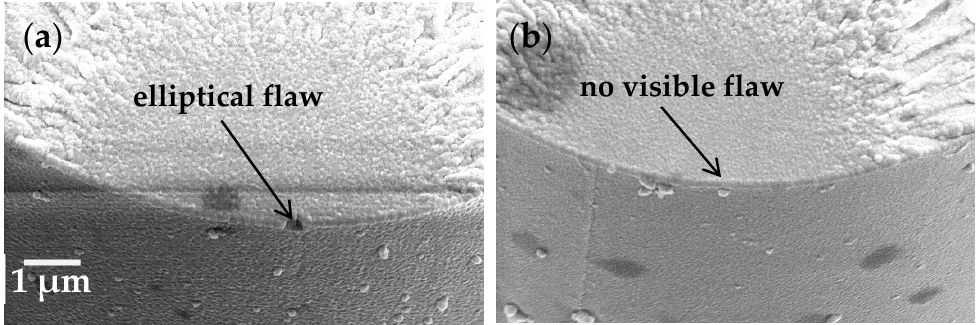
Figure 5. SEM images of fracture surfaces of two fibres vacuum conditioned at 450 °C: ( a ) showing visible flaw at which failure was initiated, ( b ) showing no visible flaw at the origin of failure.